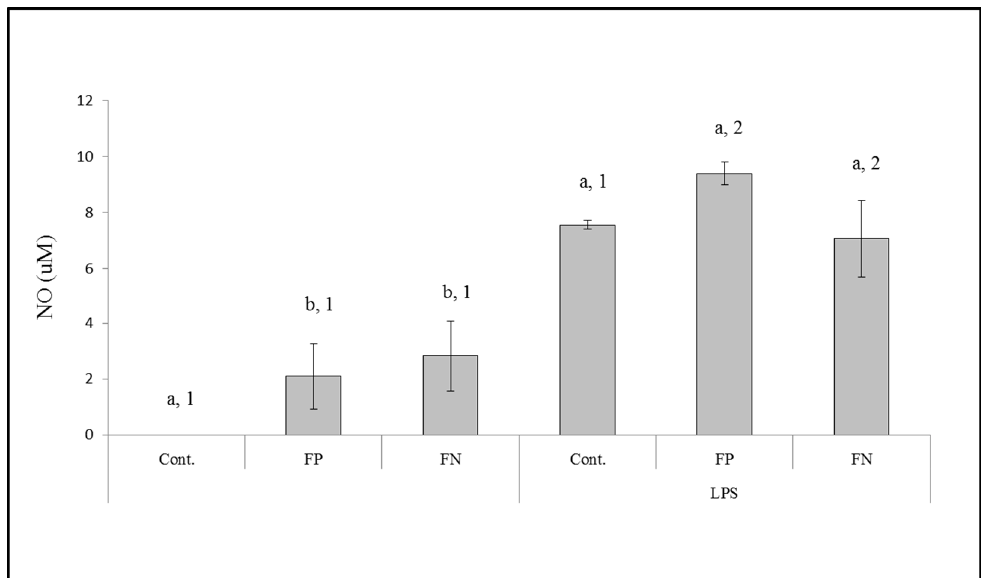
Figure 7. The effect of FP and FN on nitric oxide (NO) production by RAW 264.7 murine macrophages in the absence or presence of lipopolysaccharides (LPS). Different letters (a,b) represent significant difference between FP or FN at different concentrations; different numbers (1,2) represent the significant difference between FP and FN in the same concentration by ANOVA followed by Newman-Keuls test ( p < 0.05).